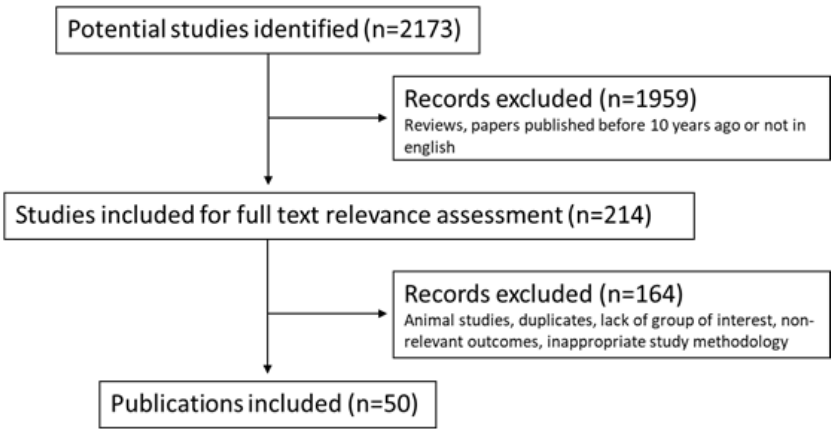
Figure 5. Flowchart of the literature eligibility assessment process.